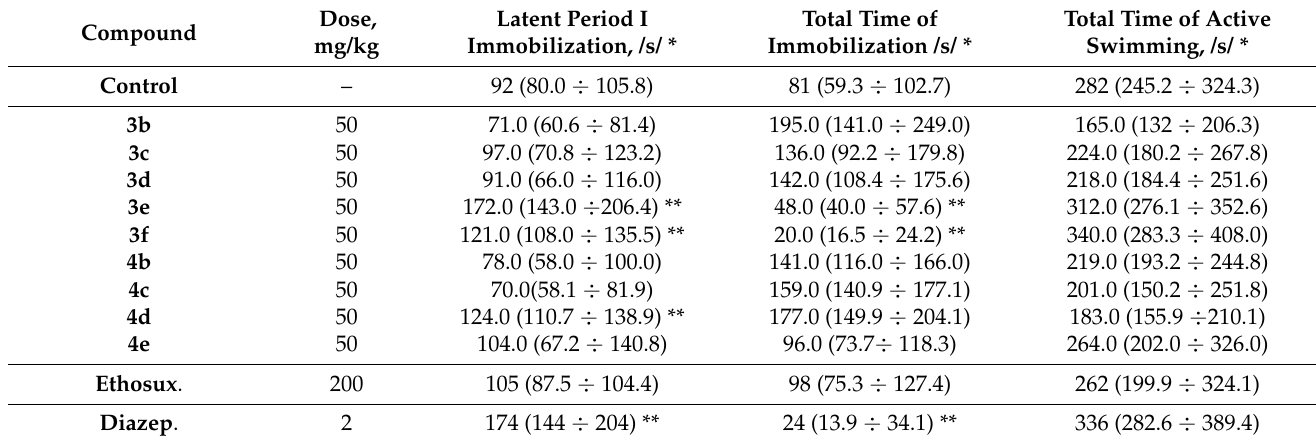
Table 6. Effect of compounds 3b , 3c , 3d , 3e , 3f , 4b , 4c , 4d and 4e on the ”forced swimming” (observa- tion time 6